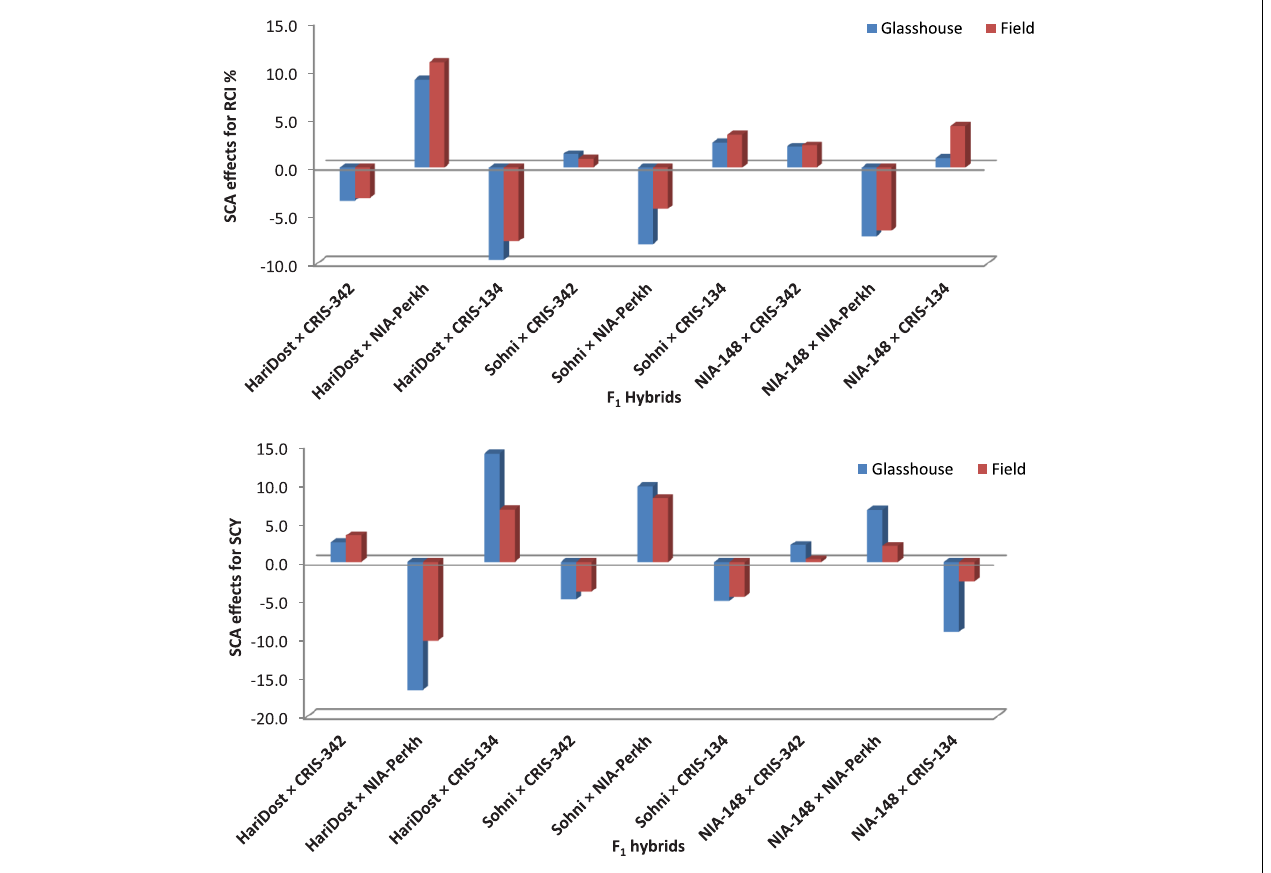
FIGURE 7 | Estimates of SCA effects for RCI% and SCY (g/plant) in F 1 generation of cotton genotypes in heat-stress (glasshouse) and non-heat-stress (field) conditions.